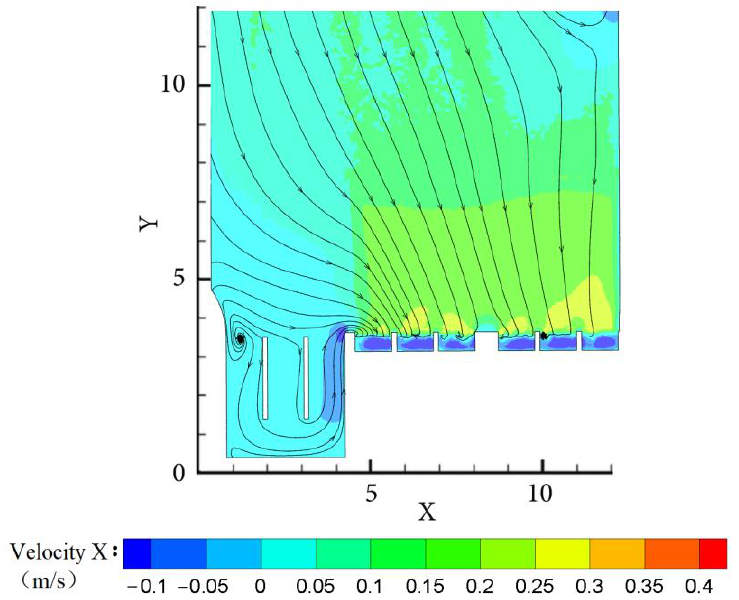
Figure 9. Flow field diagram of the bottom horizontal section (operational state of pumping).